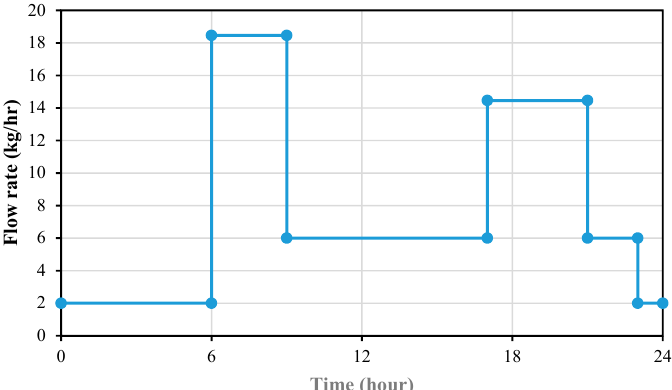
Figure 9. Hourly hot water flow rate used profile for one person in one day.